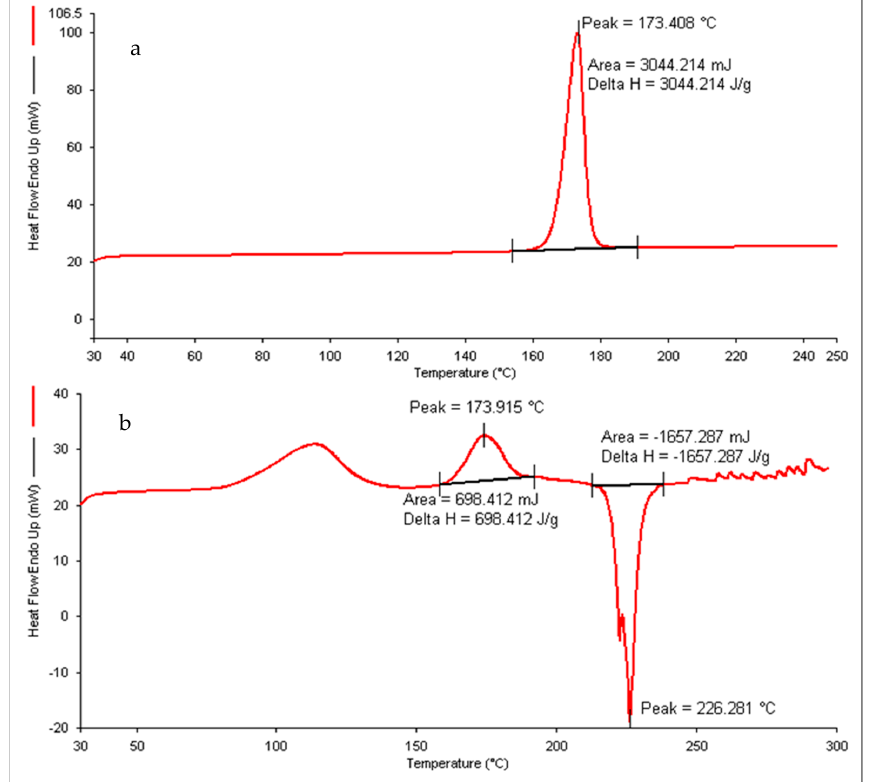
Figure 3. Differential scanning calorimetry (DSC) thermogram of ( a ) minocycline nanoemulgel (NEG) and ( b ) pure minocycline.